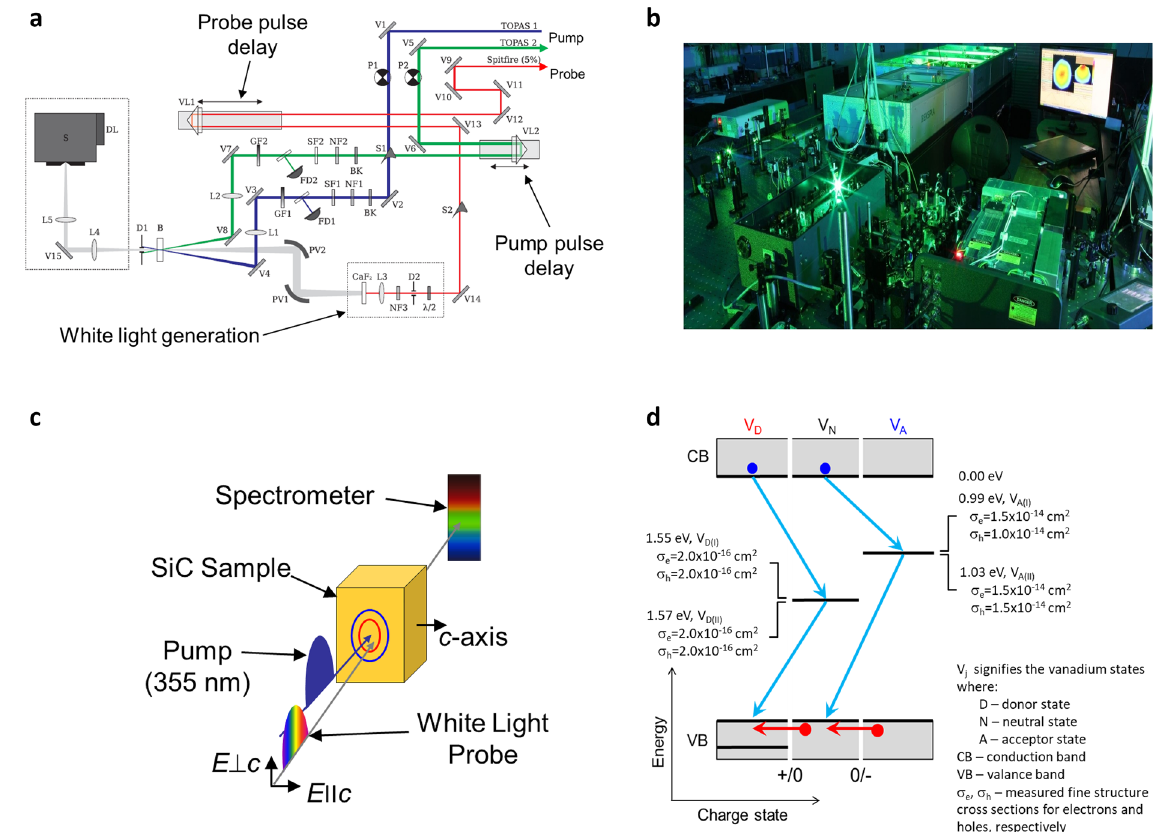
Figure 2. SI SiC carrier dynamics measurements. ( a , b ) 75-fs pulses were generated with a Ti:sapphire laser at the 800-nm fundamental wavelength. Pump wavelength was converted to 355-nm by a parametric frequency converter while probe wavelength was transformed to a white light continuum by a sapphire plate. Measurement geometry is shown schematically in ( c ); both beams were focused (d spot ~ 100-μm) and near perpendicular to the sample surface. Probe beam polarization could be oriented either parallel ( E ∥ c ) or perpendicular ( E ⊥ c ) to the principal “c” crystal axis. ( d ) The resultant bandgap model shown schematically with our highly refined spectra and cross section measurements. We deviate from previous approaches by also including the charge state of the vanadium (see “Methods” section). By imposing the conditions of energy and charge conservation, the allowable transitions for electrons (blue) and holes (red) are also shown. This model serves as the basis of the target analysis of the data from which we can determine coefficients for a coupled set of first order rate equation 32 . ( e ) Time evolution of the GTA plot for different V concentrations shows the centroid remained constant for E ∥ c (2.08-eV) and E ⊥ c (2.66-eV). ( f , g ) summarize the fast and slow component data as a function of V concentration and the model fit and indicates a very prompt carrier excitation on the order of the excitation pulse width. V concentration is shown in Table 1. In ( g ), increased decay occurred at increased V concentration until about 10 16 -cm −3 . At about that concentration level, a fast-initial decay with a long tail starts to emerge and becomes dominant at a V concentration of > 7 × 10 15 -cm −3 . This result suggests that the standard Shockley– Read–Hall recombination model is inadequate, particularly with high V concentrations. ( h ) Shows the free carrier absorption (FCA) shortly after the initial pump (∆t = 1 ps) and at late time (∆t = 7 ns) and the model